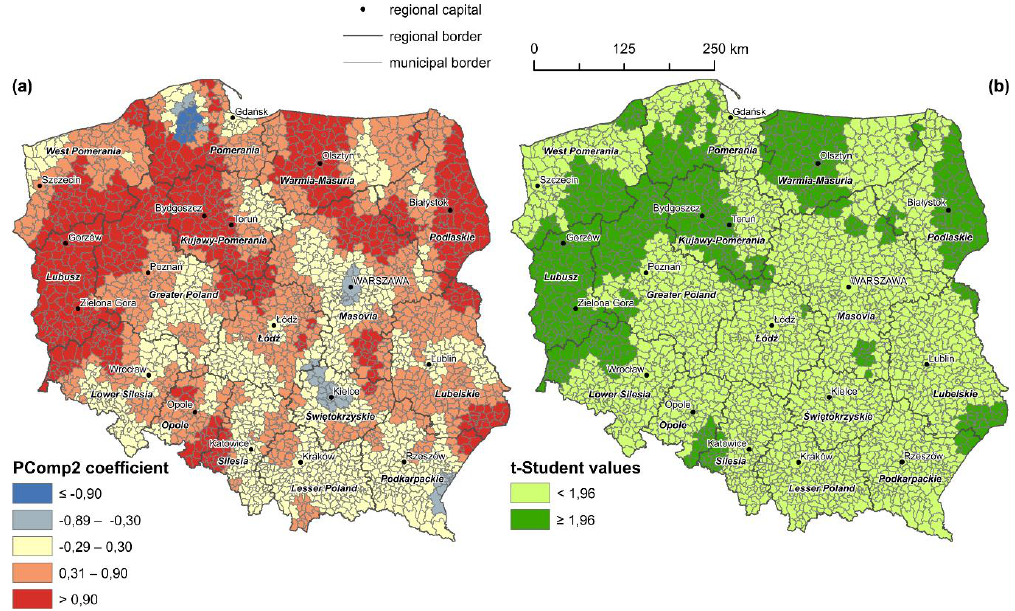
Figure 6. Value ( a ) and significance ( b ) of impact of the second component “environment” on land cover changes in Poland, in the years 2012–2018.